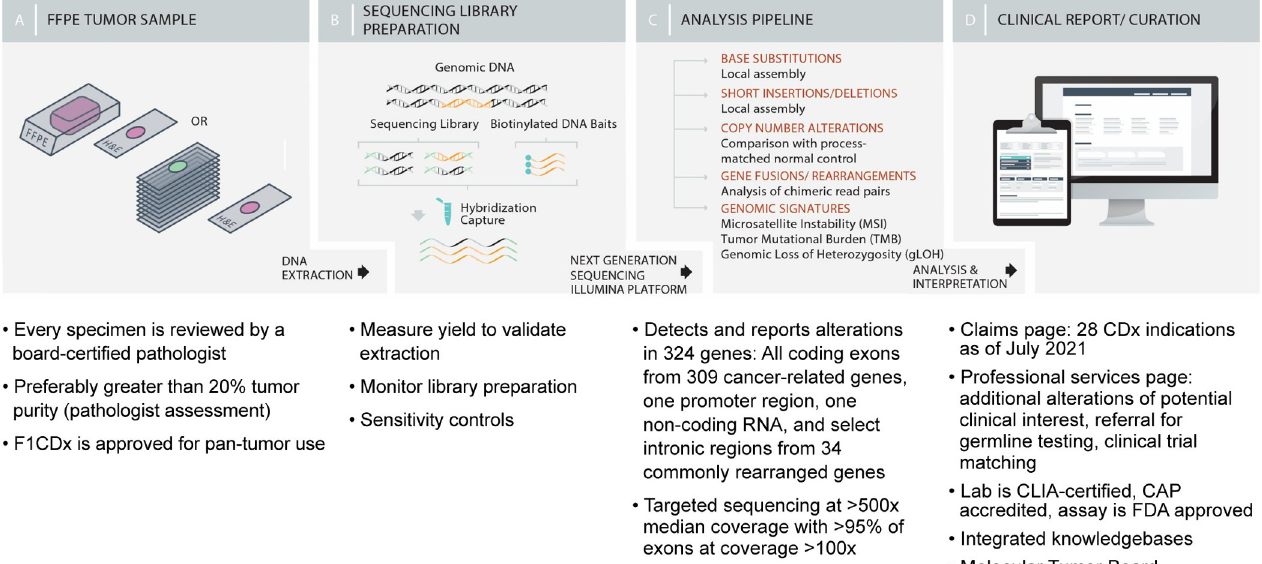
PLOS ONE | https://doi.org/10.1371/journal.pone.0264138 March 16,